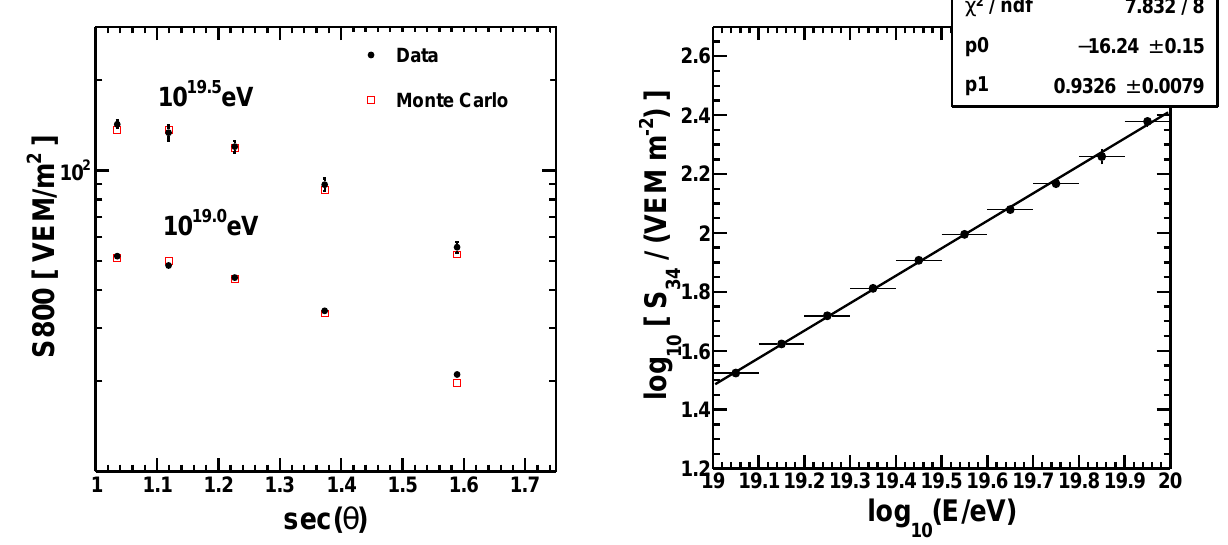
Figure 6. Left: The CIC attenuation comparisons between the data (black solid points) and the Monte Carlo (red open squares), for two energy thresholds, 10 19 . 0 and 10 19 . 5 eV. Right: The energy estimator log the Monte Carlo events. Solid line shows the linear